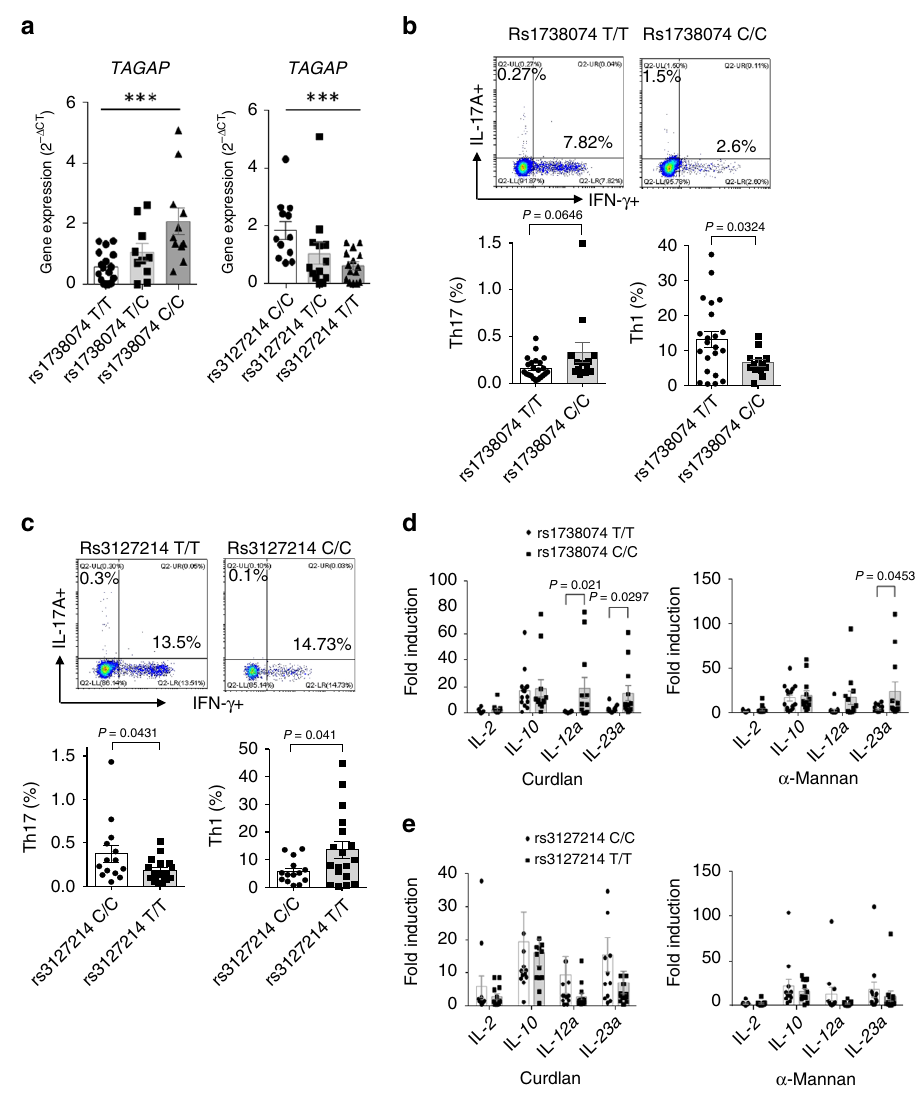
Fig. 7 TAGAP expression level correlates positively with Th17 cell abundance in humans. a Human PBMCs were divided in different groups based on the TAGAP SNP genotypes, and TAGAP mRNA expression was analyzed by RT and real-time PCR. Each dot in the data represent the data from each individual ( n = 17, 10, 11 for rs1738074; n = 12, 13, 15 rs3127214). b , c Human PBMCs of TAGAP rs1738074 T/T and C/C b or TAGAP rs3127214 C/C and T/T c were analyzed by fl ow cytometry by gating on CD3 + , and analyzed by IL-17A or IFN- γ -producing cells. Lower panel were quantitative results. d , e PBMCs of TAGAP different genotypes were stimulated with Curdlan (100 μ g/ml) or α -Mannan (100 μ g/ml) for 3 h, followed by real-time PCR analysis of